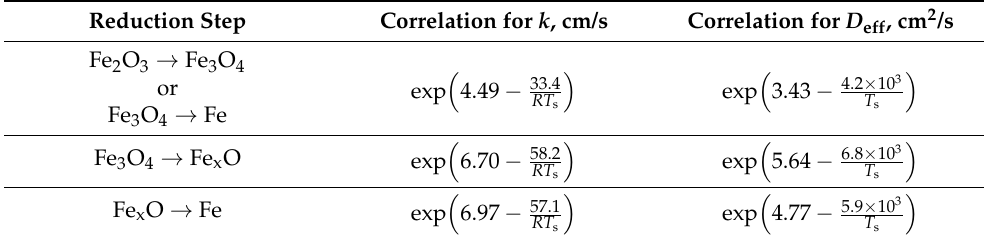
Table 1. Correlations [16] of chemical reaction rate constant ( k ) and effective diffusion coefficient ( D eff ) concerning H 2 reduction of the pellets considered in the model.